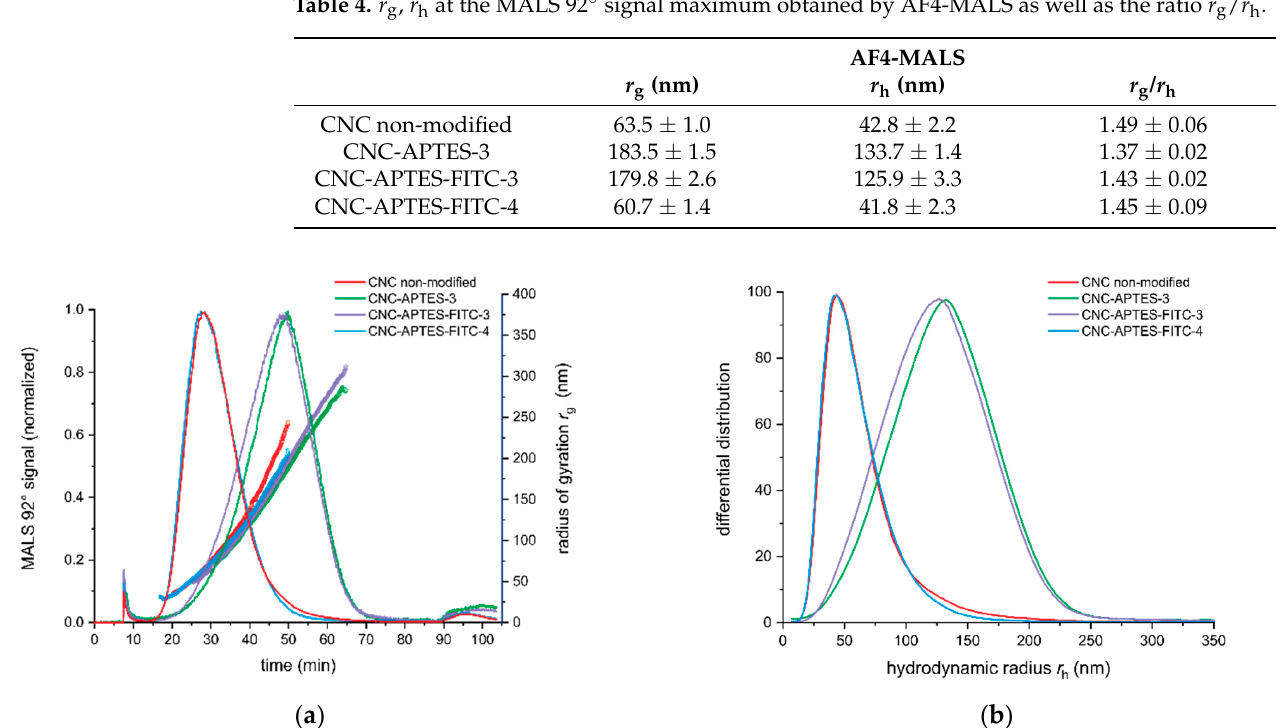
Table 4. r g , r h at the MALS 92° signal maximum obtained by AF4-MALS as well as the ratio r g / r h .